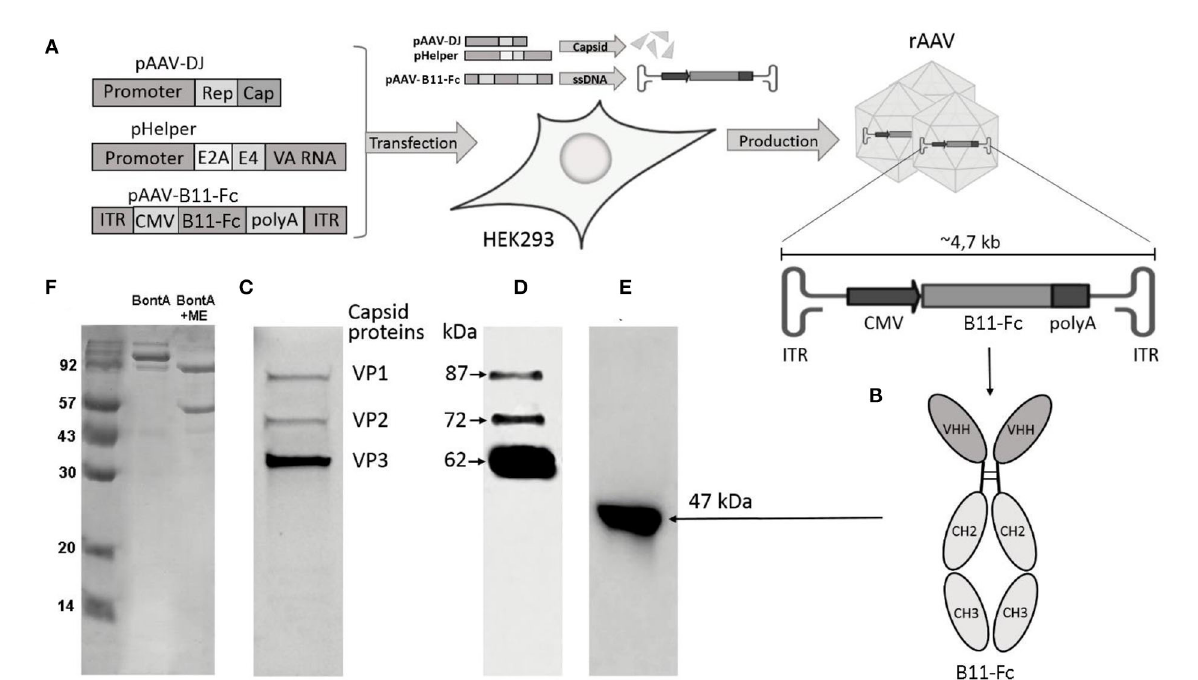
FIGURE1 Key methods and experimental results. (A) Scheme of rAAV-B11-Fc production. Plasmids pAAV-DJ, pHelper, and pAAV-B11-Fc are cotransfected in HEK293 cells for rAAV-B11-Fc production; (B) Diagram of B11-Fc antibody structure; (C) SDS–PAGE of purified rAAV-B11-Fc under reducing conditions; (D) Immunoblot of purified rAAV-B11-Fc under reducing conditions with specific antibodies to the capsid proteins anti-VP1, VP2, and VP3; (E) Culture medium from HEK293 cells transduced with purified rAAV-B11-Fc; (F) SDS–PAGE of BoNT/A at reducing and non-reducing